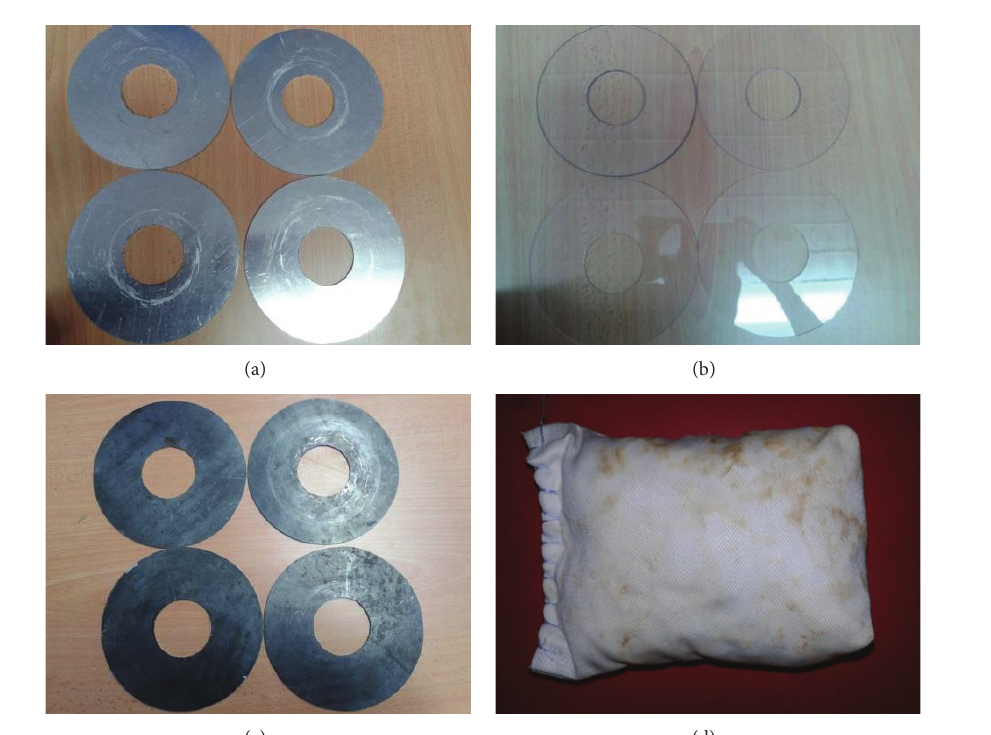
Figure 3: Used countermeasures in laboratory; (a) aluminum collar, (b) Perspex collar, (c) steel collar, and (d) geobag with crushed concrete containing oil palm